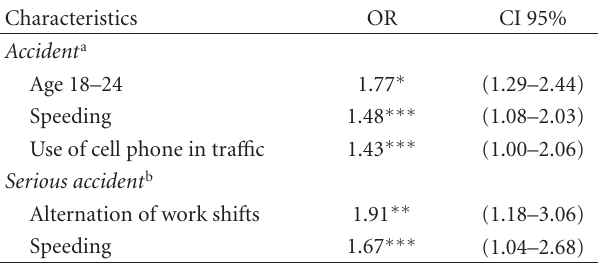
Table 3: Multivariate analysis for reports of road accidents and serious road